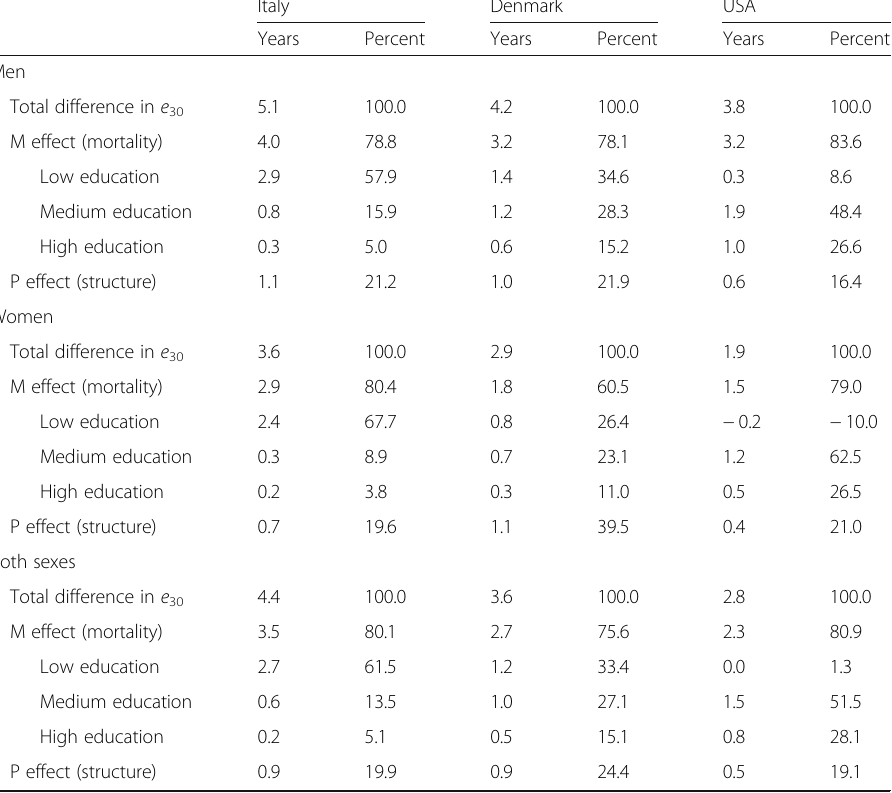
Table 3 Contributions of changes in mortality (M effect) and populations ’ educational structure (P effect) to differences in life expectancy at age 30 ( e 30 ) for Italy (1991 – 2011), Denmark (1990 – 2010), and the USA (1990 – 2010), stratified by gender Italy Denmark